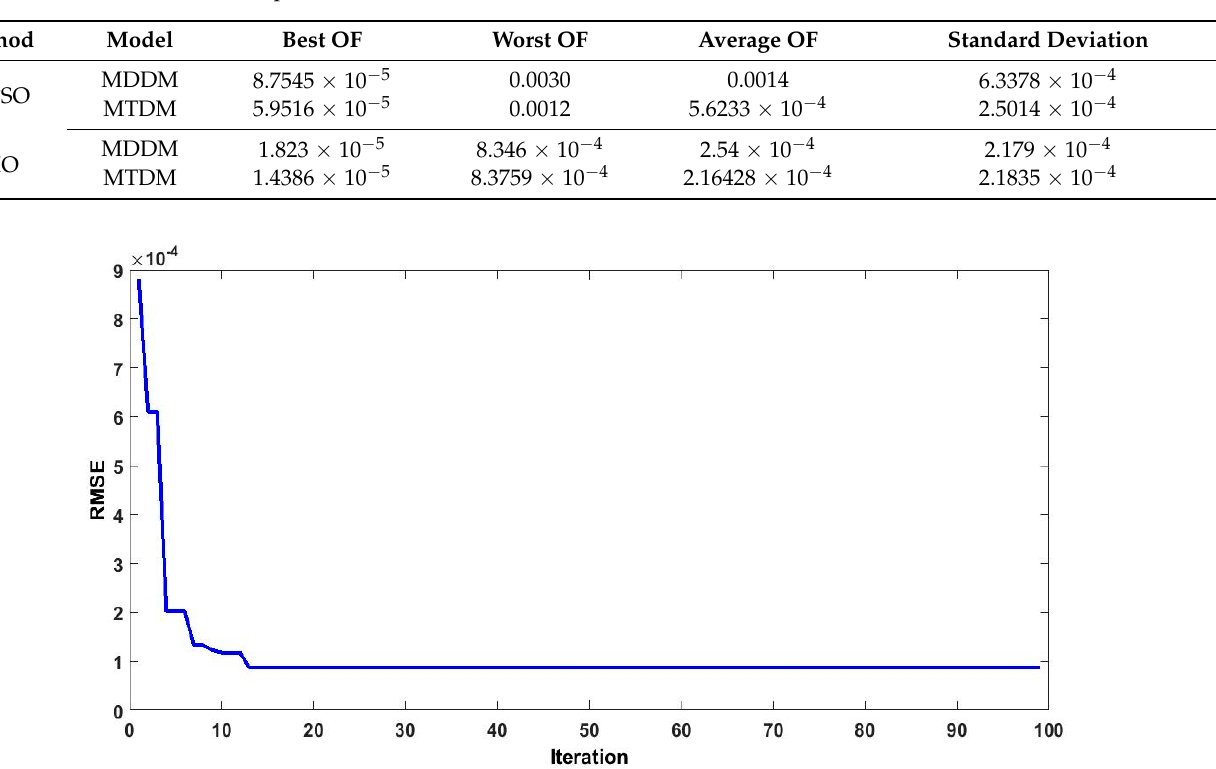
Figure 4. Convergence rate of the MTDM using CLPSO. Figure 5. Convergence rate of the MDDM using EHO.